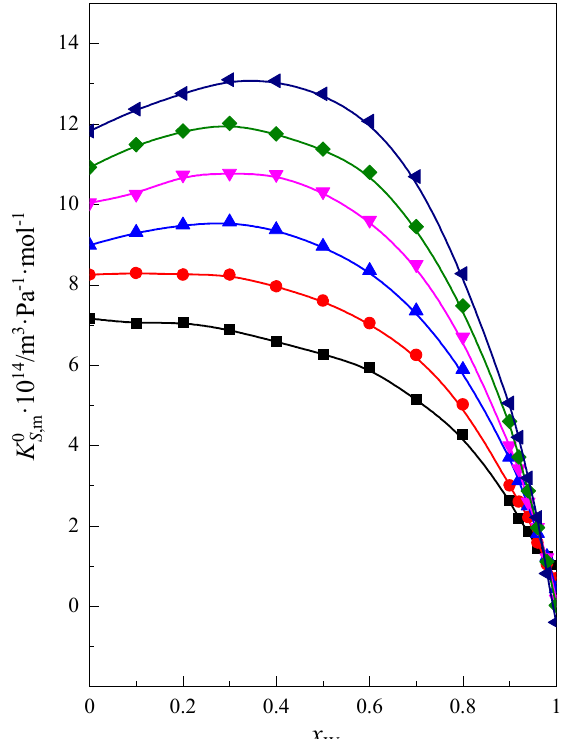
■ pentaglyme, Figure 1. Limiting partial molar volume of